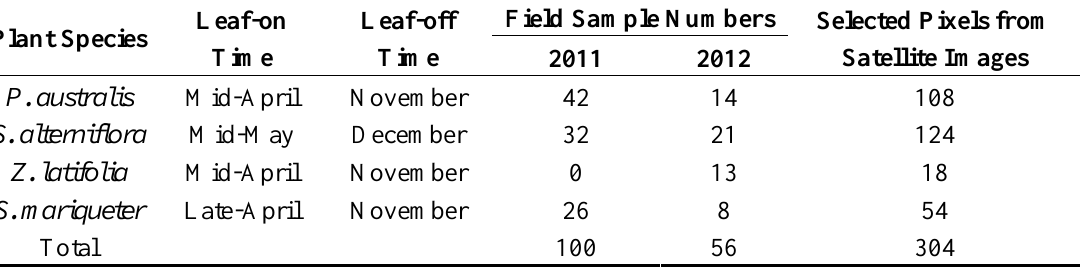
Table 2. The leaf-on and leaf-off phenophases of different plant species and sampling numbers from field investigation and satellite images Plant